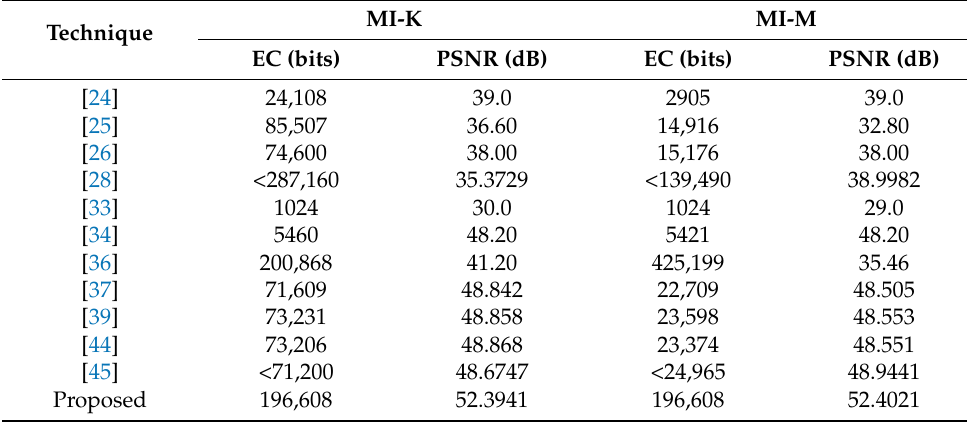
Table 7. Comparison of the proposed scheme for Lena and baboon